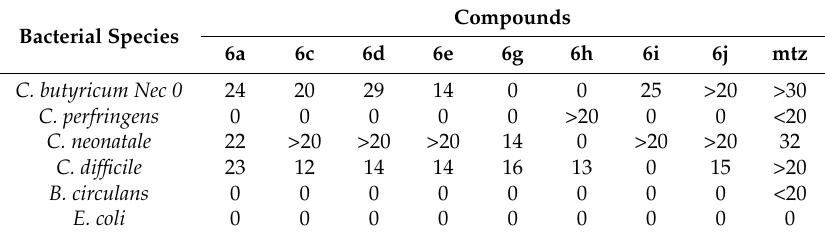
Antibacterial activity of molecules 6a – j obtained with the one-pot regioselective bis-Suzuki-Miyaura reaction.